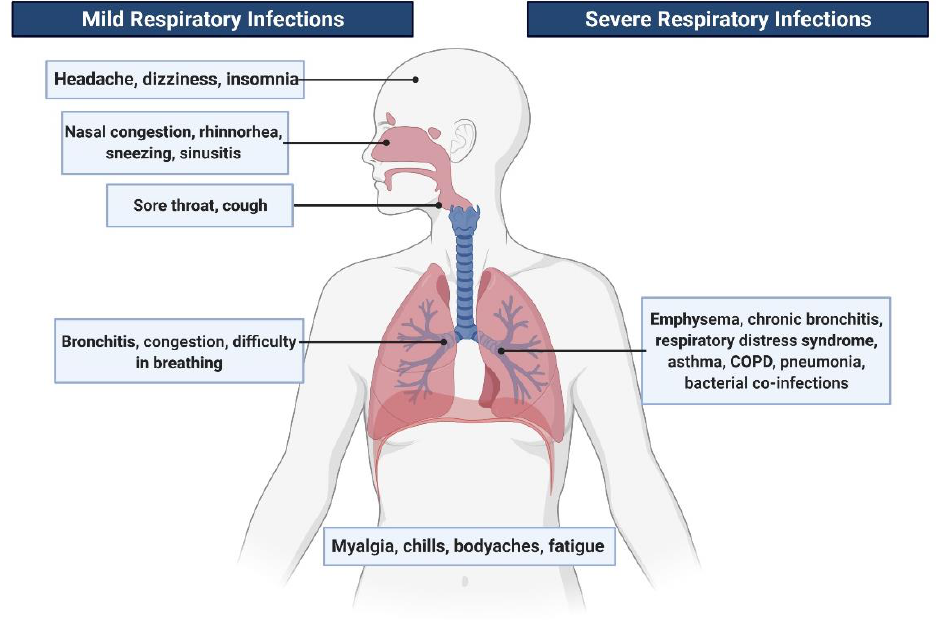
Figure 1. Symptoms related to viral respiratory tract infections.